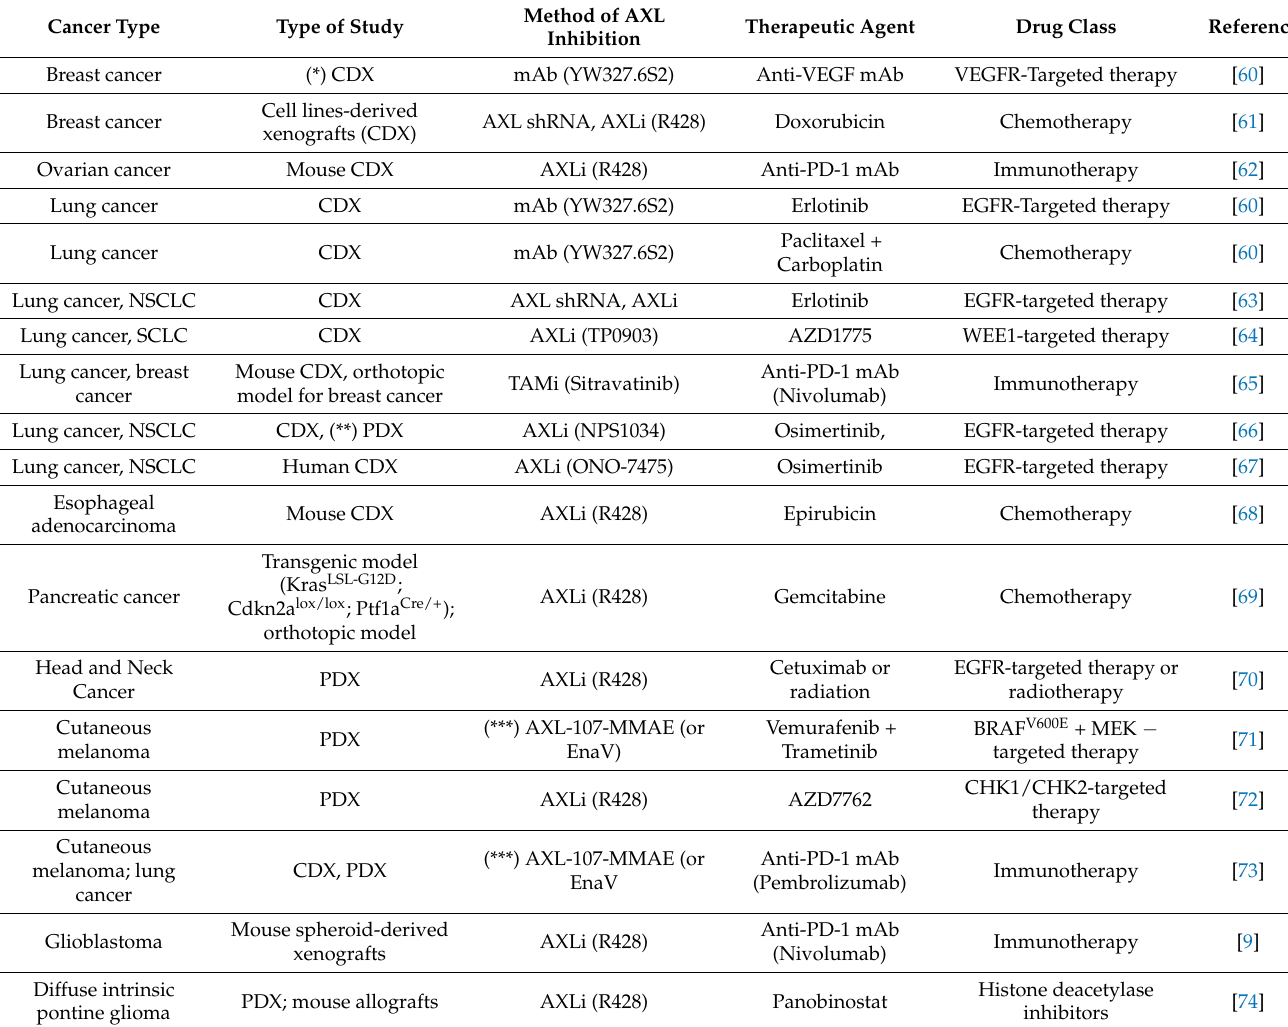
Table 1. Targeting AXL signaling sensitizes solid tumours to various therapies in